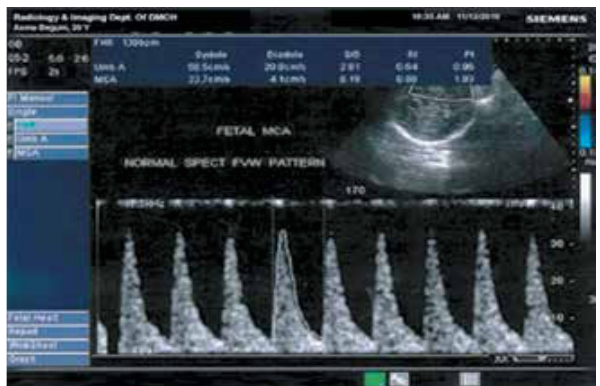
Fig 2. Color Doppler of the normal middle cerebral artery showing a normal MCA waveform pattern with high resistance, low diastolic flow and increased pulsatility index